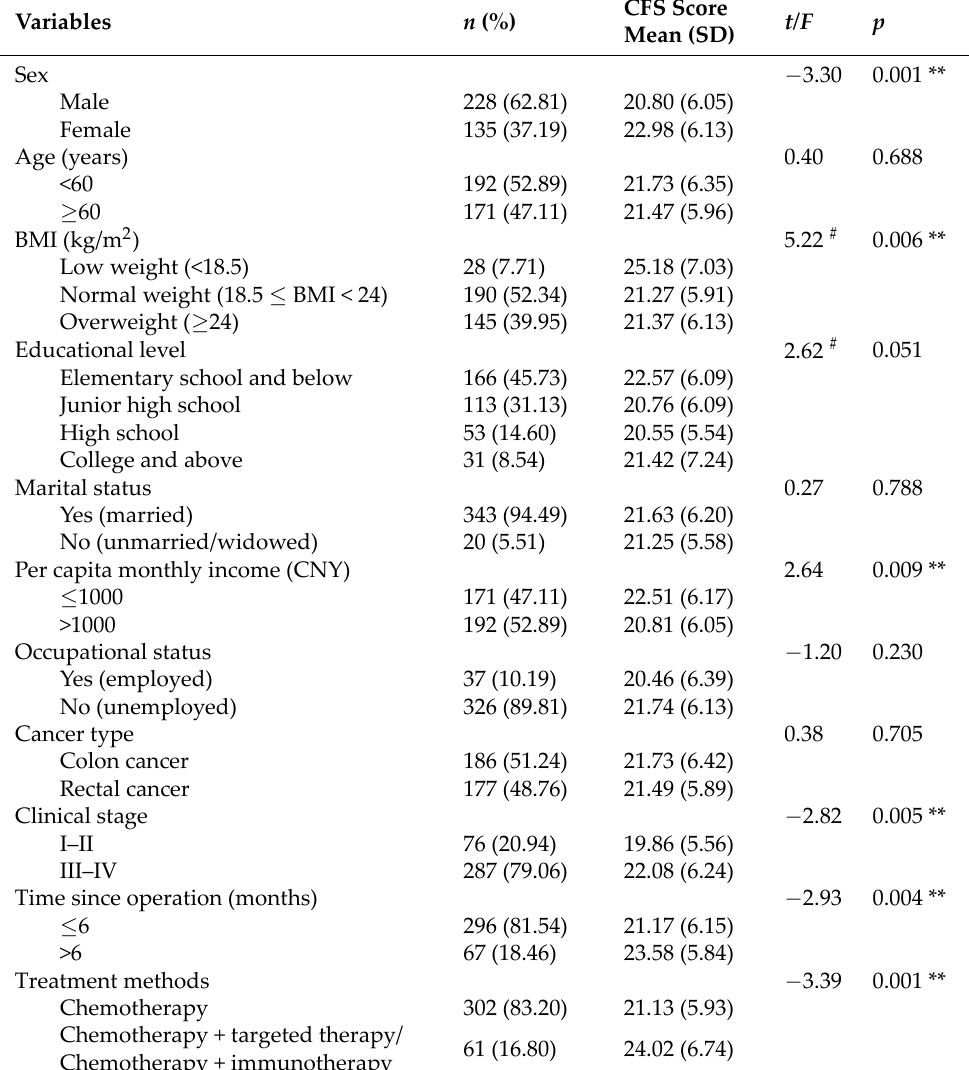
Table 1. General characteristics of the sample, comparisons of CFS score among different sample groups ( n =